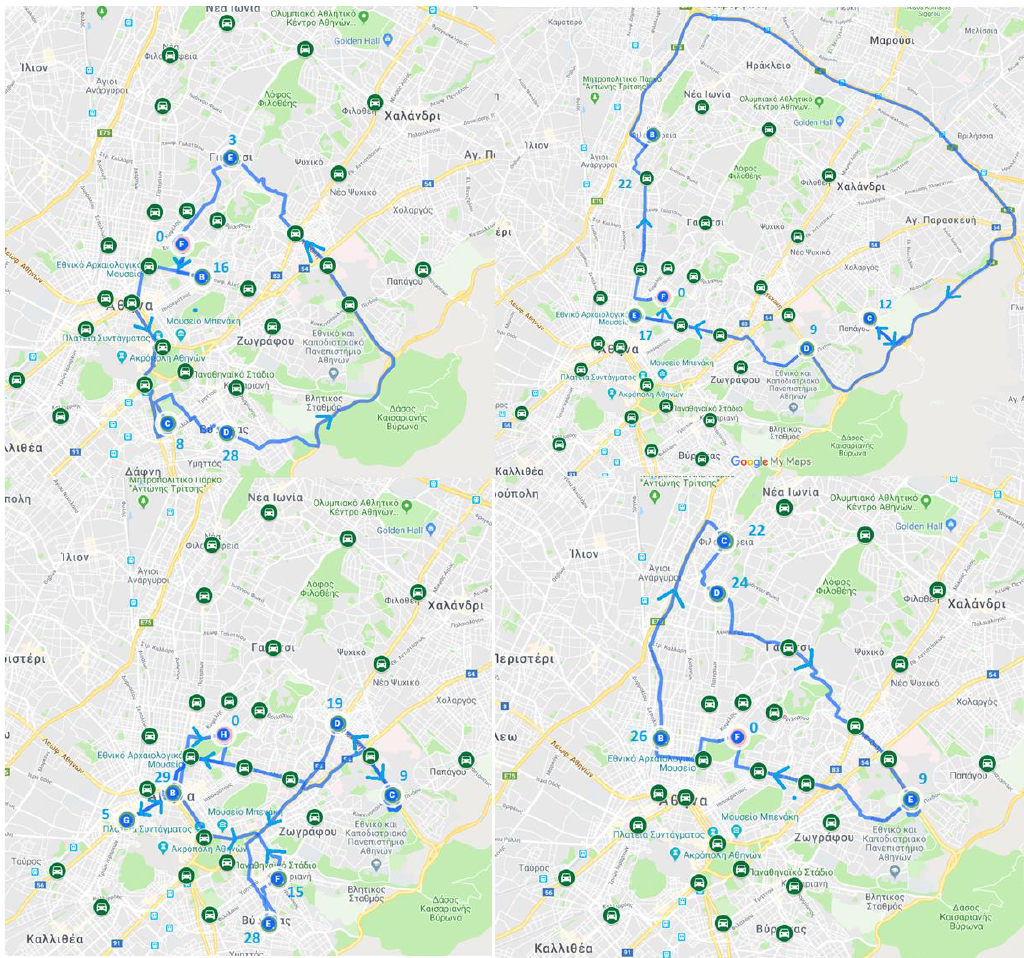
Figure 4. Routes for vehicles 5 (top left), 6 (top right), 7 (bottom left), 8 (bottom right).